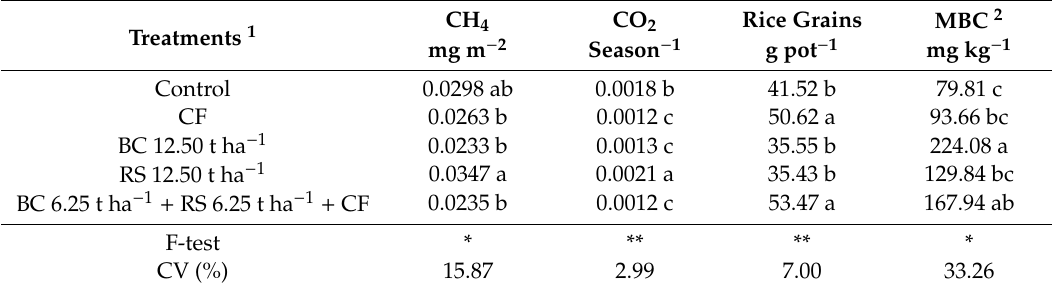
Table 3. CH 4 , CO 2 emissions, rice grains, and microbial biomass C (MBC) in the potted rice-soil treated with BC and RS.